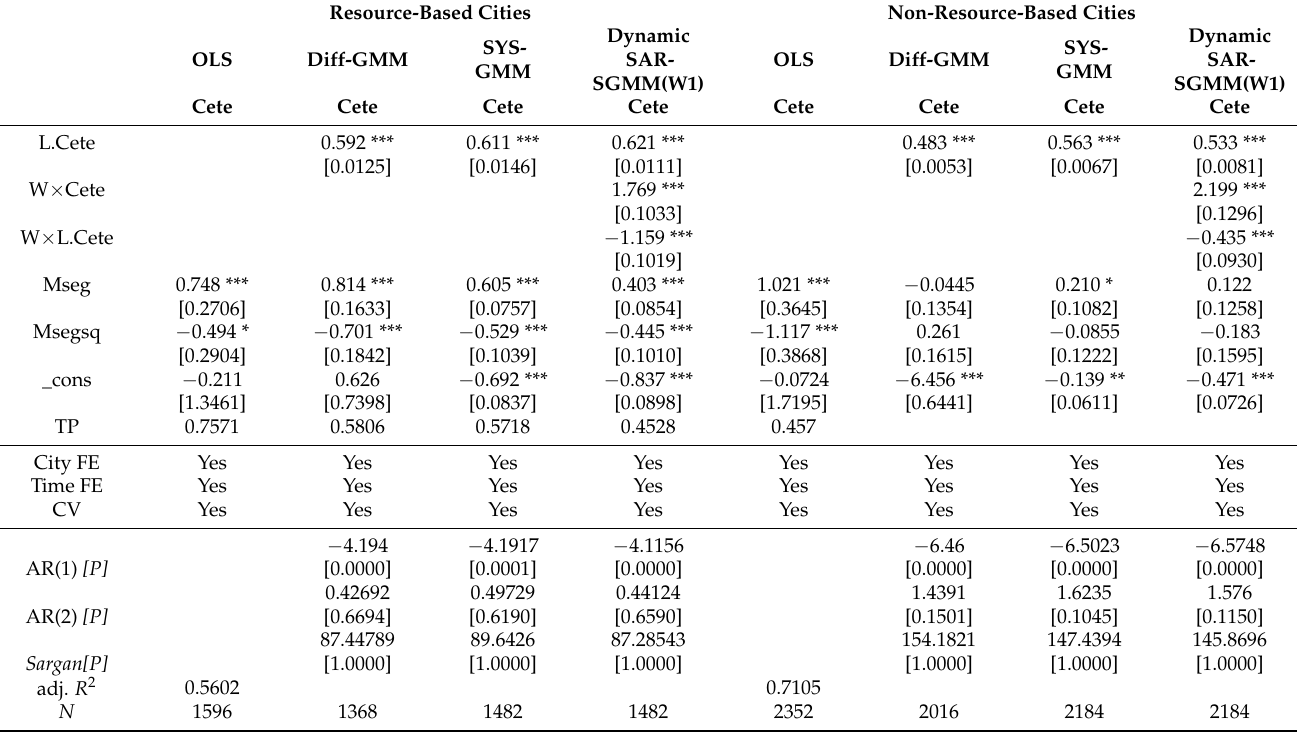
Table 11. Heterogeneity analysis regression